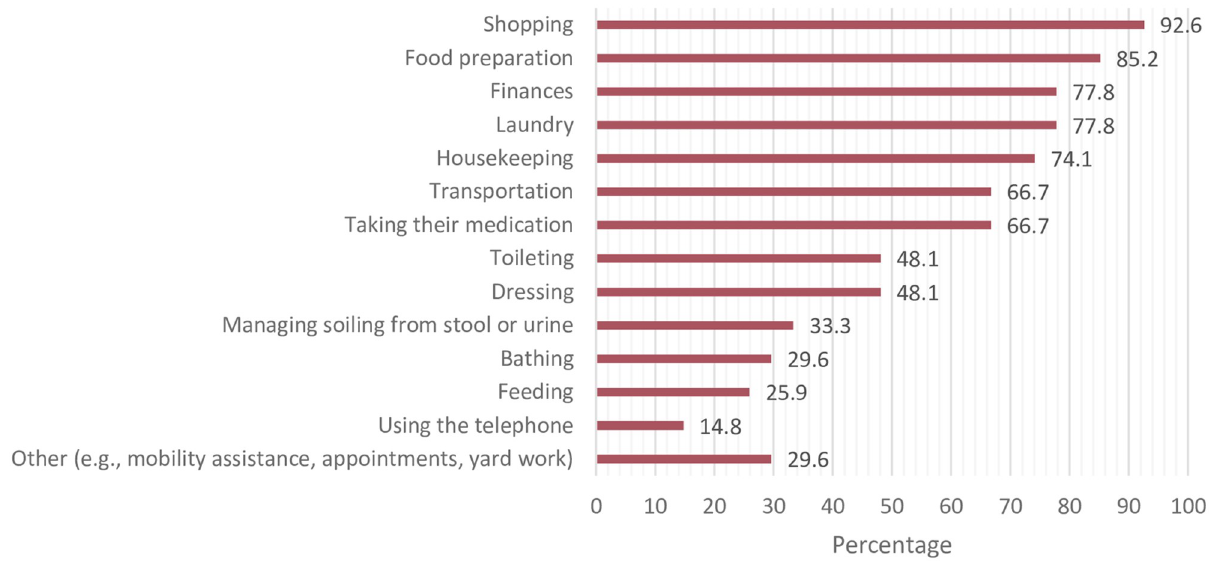
Fig 2. Types of assistance provided by caregivers (n = 27).